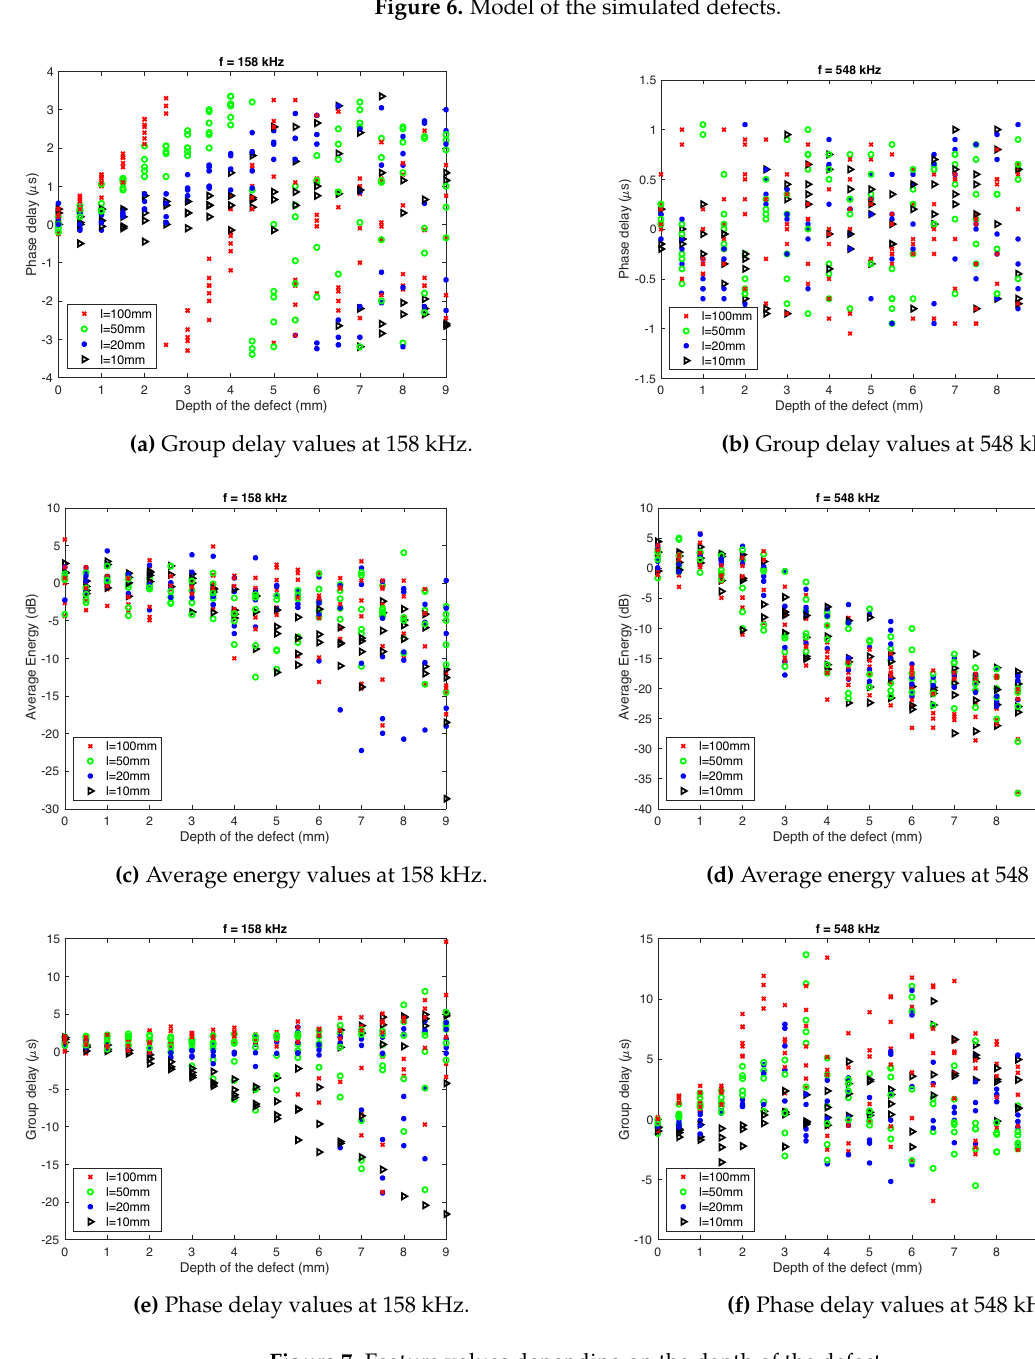
Figure 7. Feature values depending on the depth of the